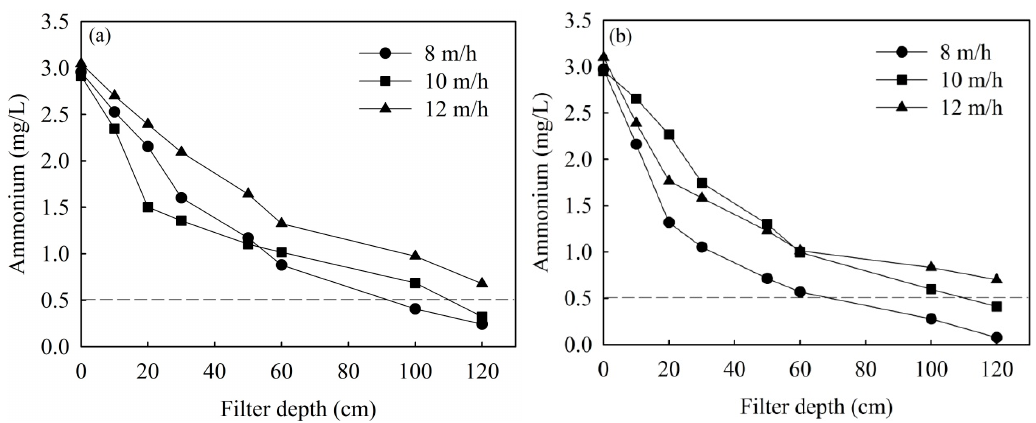
Figure 4. Ammonium removal with different filtration velocities: ( a ) pure oxygen and ( b ) Figure4. Ammoniumremovalwithdi ff erentfiltrationvelocities: ( a )pureoxygenand( b )compressedair. compressed air.